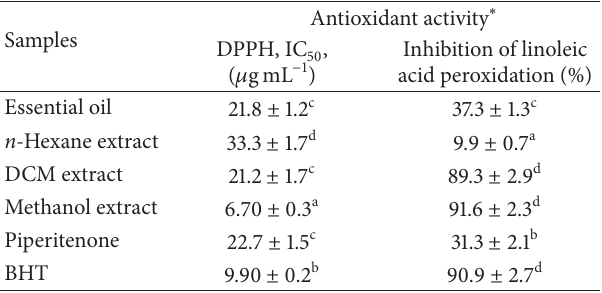
Table 3: Antioxidant activity of M. longifolia essential oil and n- hexane, dichloromethane, and methanol